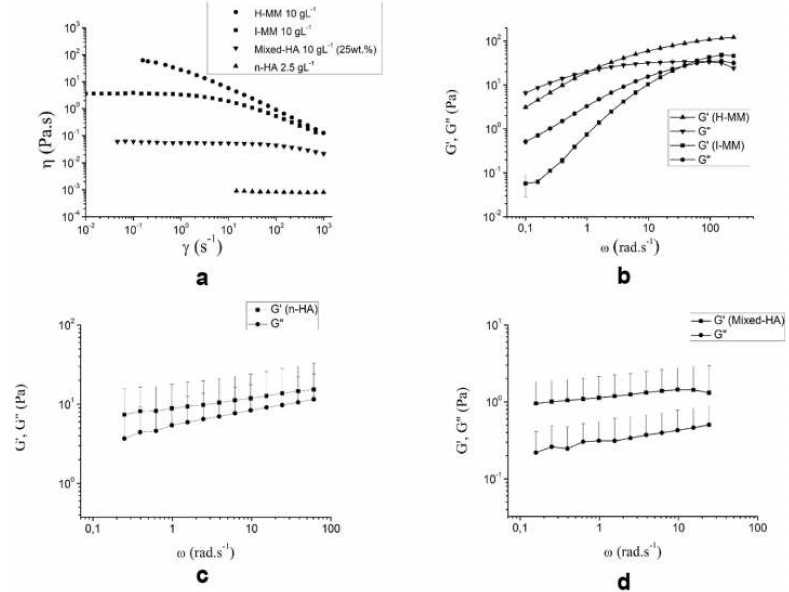
Figure 1. Rheological behavior of the free hyaluronic acids (f-HAs) with high (H-MM) ( a ) and intermediate MM (I-MM) molar mass ( b ), crosslinked HA nanoparticles (n-HA) ( c ) and mixed formulations (nanoparticles + free HA) (mixed-HA) ( d ). All formulations were bu ff ered in pH 7.4 aqueous